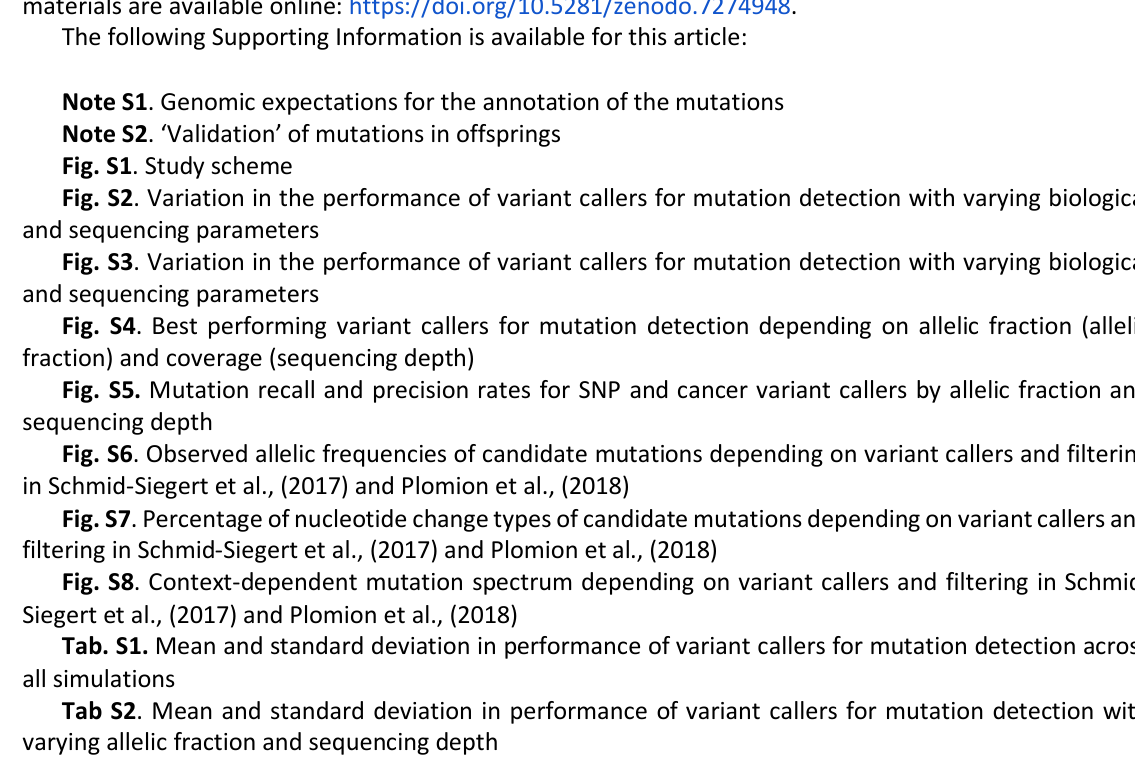
Fig. S7 . Percentage of nucleotide change types of candidate mutations depending on variant callers and filtering in Schmid-Siegert et al., (2017) and Plomion et al., (2018) Fig. S8 . Context-dependent mutation spectrum depending on variant callers and filtering in Schmid- Siegert et al., (2017) and Plomion et al., (2018) Tab. S1. Mean and standard deviation in performance of variant callers for mutation detection across all simulations Tab S2 . Mean and standard deviation in performance of variant callers for mutation detection with varying allelic fraction and sequencing